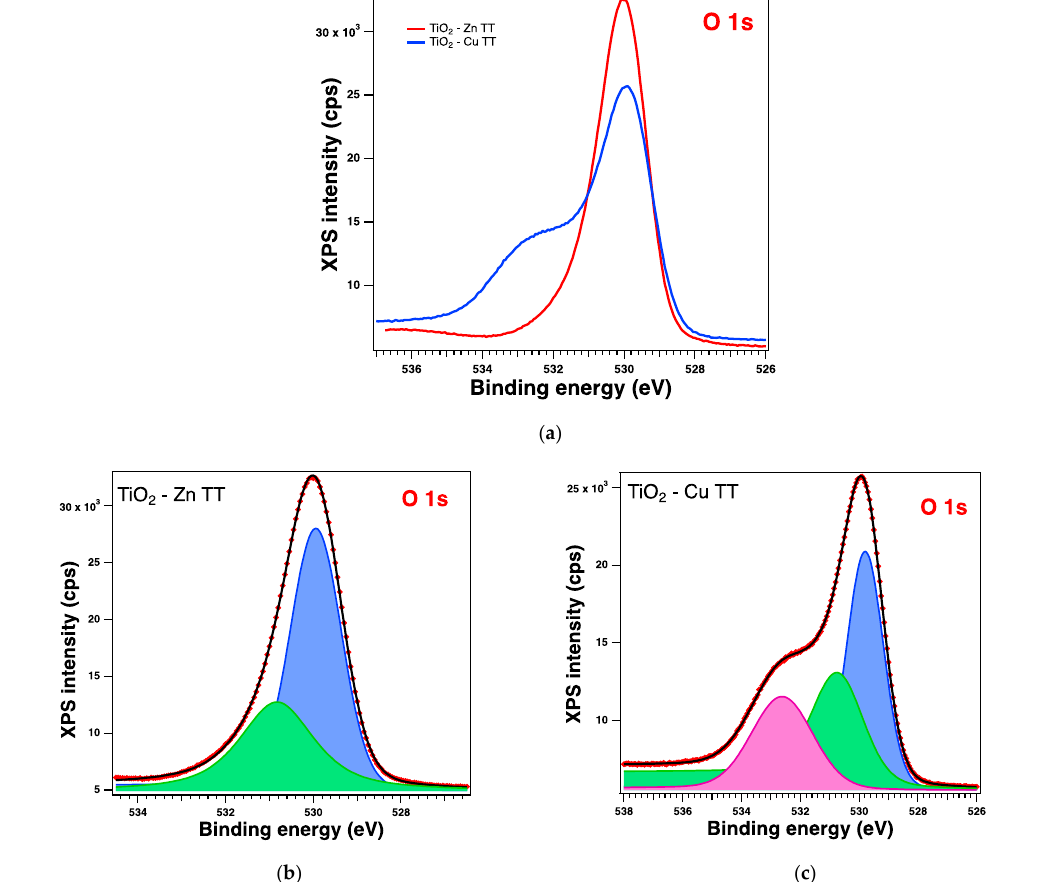
Figure 14. XPS spectra of the O 1s level for treated samples: ( a ) comparison of experimental data: red line for the Zn-doped samples and blue line for the Cu-doped samples, and ( b , c ) the fit and deconvolutions for the Zn and the Cu samples, respectively: red symbols for the experimental data overlayed with a black line, blue line for C1, green line for C2, and magenta line for C3 (for ( c ) only).